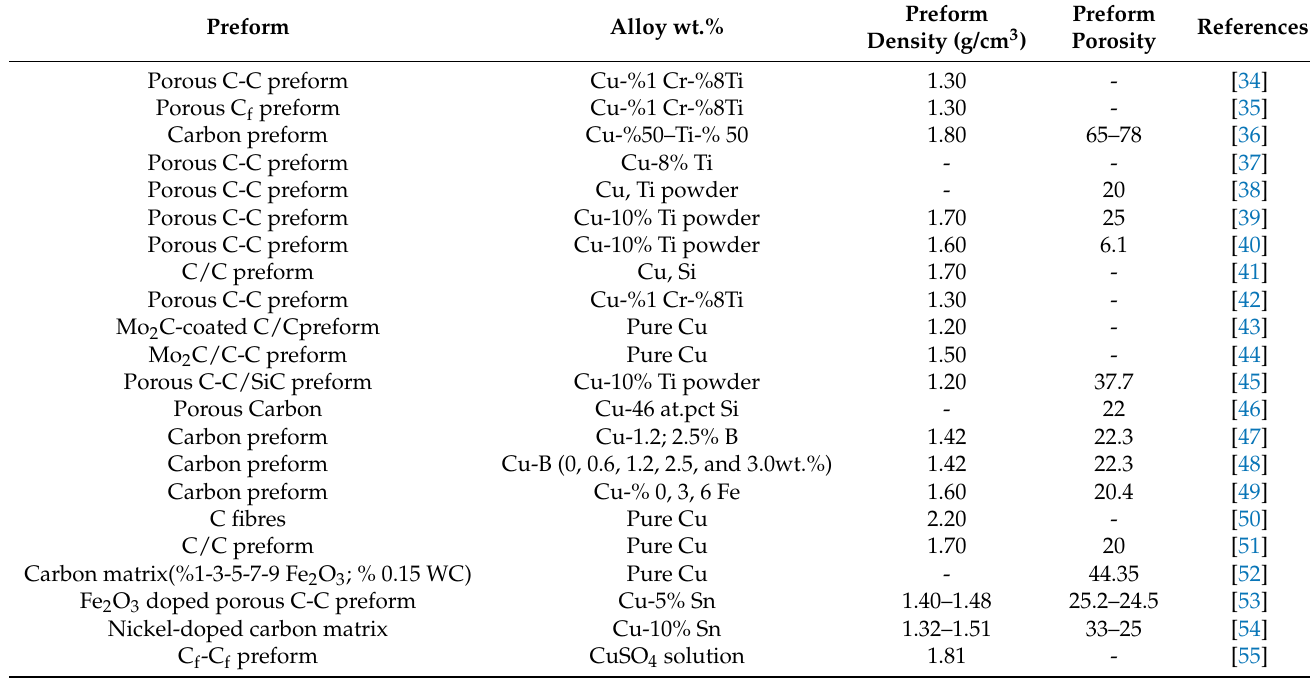
Table 1. Used starting materials, composition and their properties.